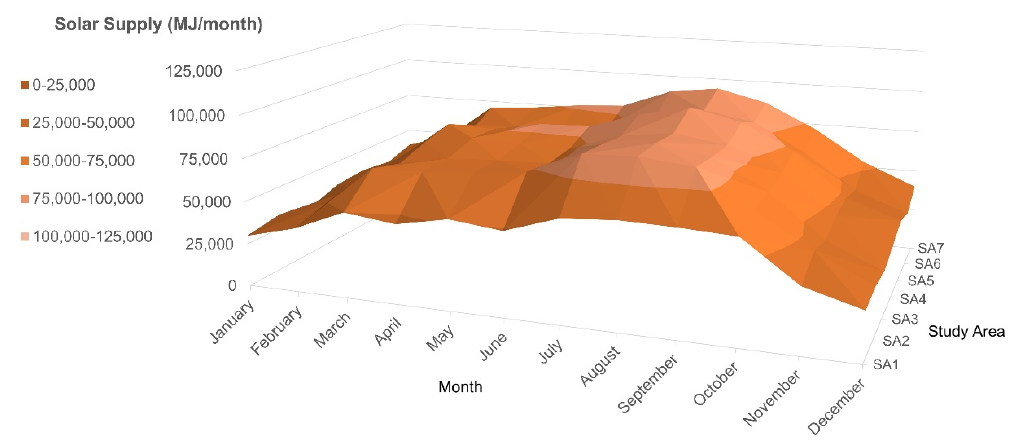
Figure 8. Solar supply in the hybrid-modular system per month by sector.